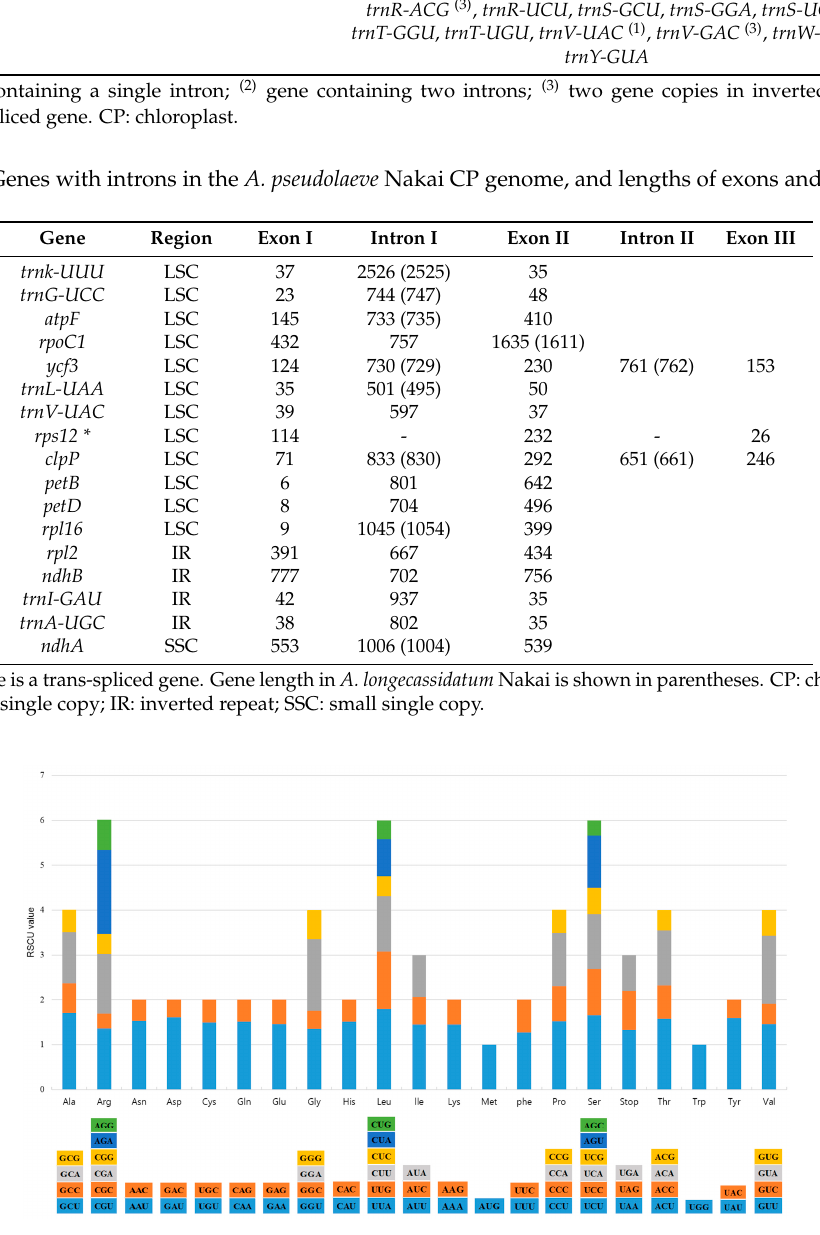
Figure 2. Codon content for the 20 amino acids and stop codon in 78 protein-coding genes in the A. pseudolaeve Nakai and A. longecassidatum Nakai CP genomes. Colors in the column graph reflect codons in the same colors shown in the lower part of the figure. RSCU: relative synonymous codon usage; Ala: alanine; Arg: arginine; Asn: asparagine; Asp: asparagine; Cys: cysteine; Gln: glutamine;